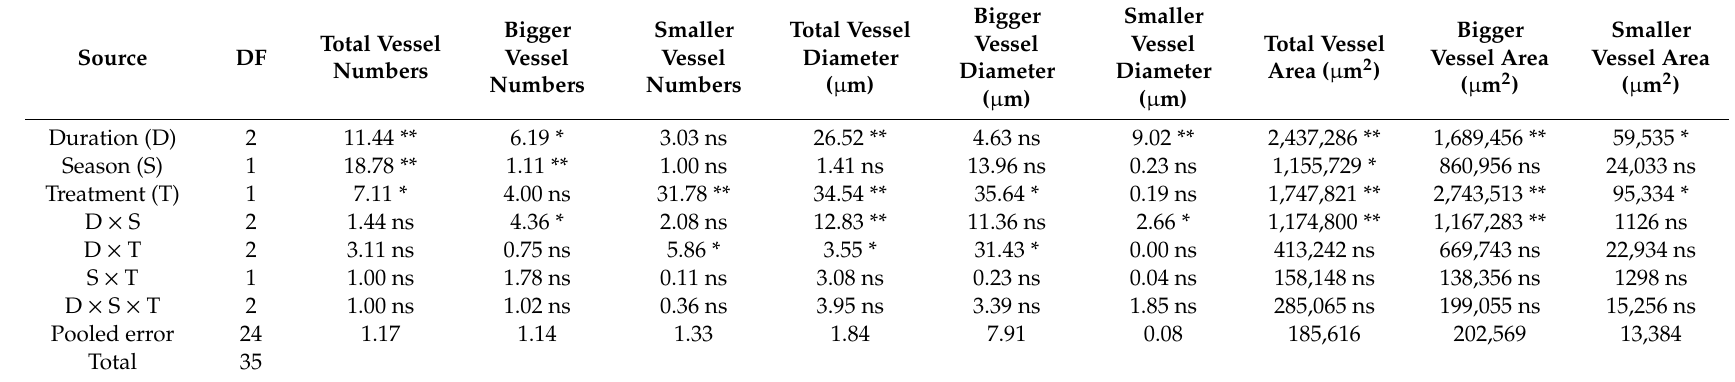
Table 2. Mean square from the combined analysis of variance for total vessel numbers, bigger vessel numbers, smaller vessel number, total vessel diameter ( µ m), in 2013 and